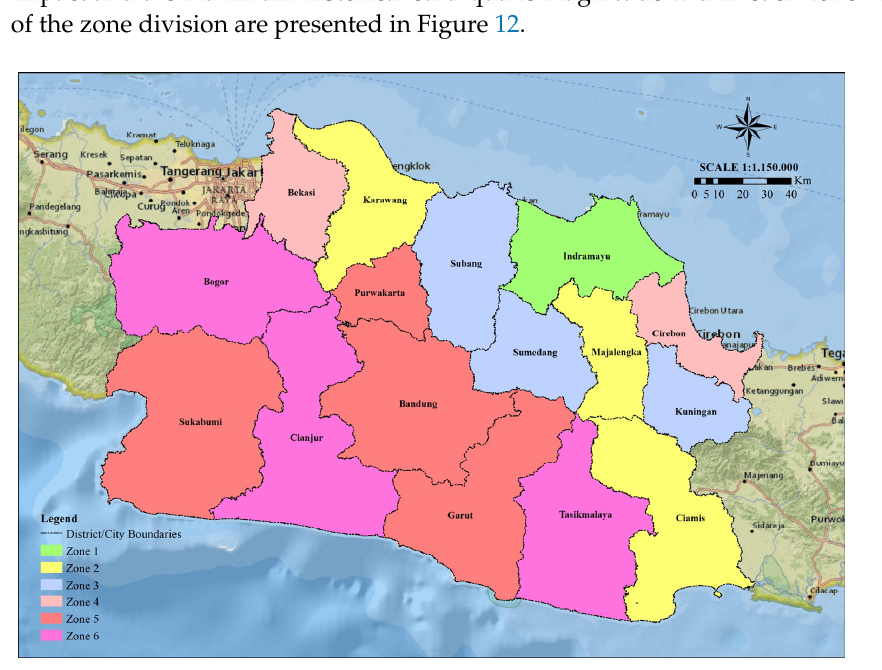
Table 8. The results of dividing the zones of West Java Province using clustering of type II. Zone Member of Cluster